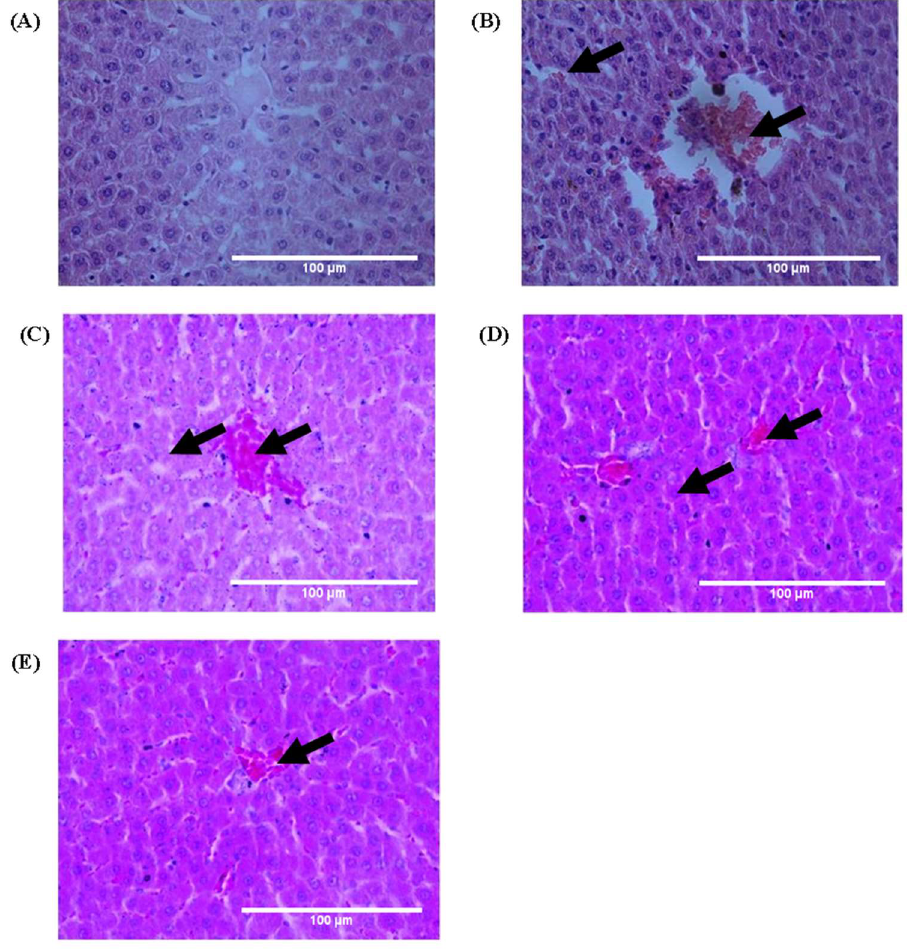
Figure 6. AAE improved architecture of hepatocyte lesions and inflammation. ( A ) H&E stain (40X) of Group I exhibited normal cells having well-preserved granulated cytoplasm and sinusoidal spaces with prominent nucleus and nucleolus. ( B ) Liver section from ethanol-intoxicated rats exhibited disarrangement of normal hepatic cells with centrilobular necrosis, vascular and cellular degeneration, with inflammation. ( C – E ) Administration of AAE in Groups III and IV exhibited reduction in necrosis with decreased inflammation, and improved the architecture of hepatocytes; improvement level in Group IV was much better than that of Group III and close to that of Group V. Arrows indicates the improvement in centrilobular necrosis, vascular, cellular degeneration and inflammation after AEE treated